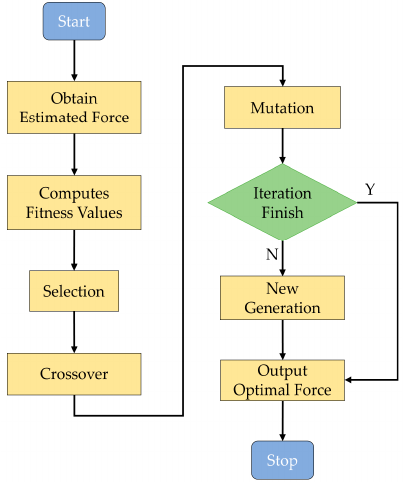
Figure 4. Flow chart for the correction force search with evolutionary strategy algorithm.